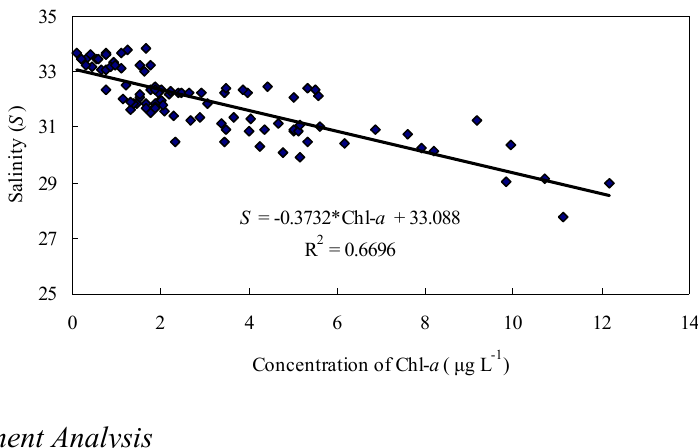
Figure 4. Relationship between Chl- a and salinity.